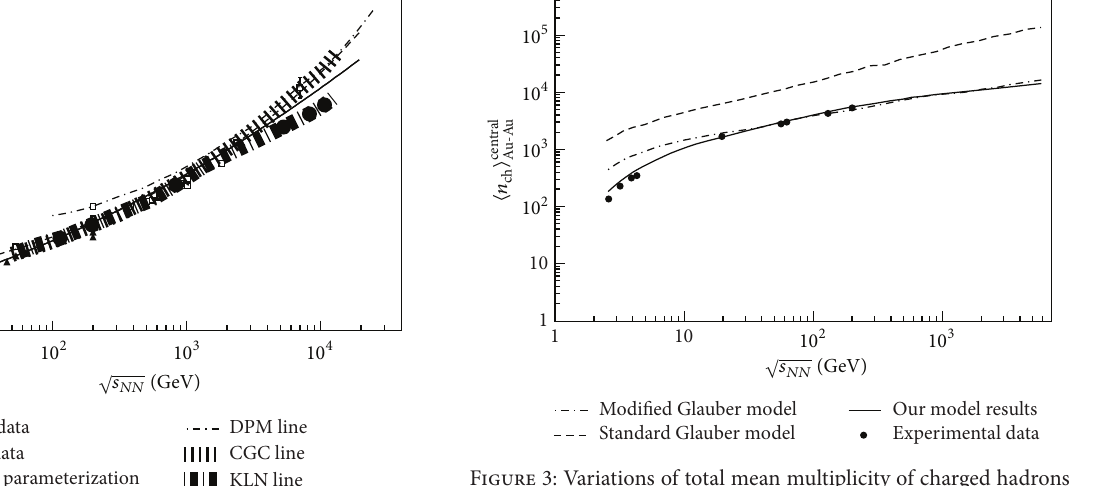
) produced in Au- ch